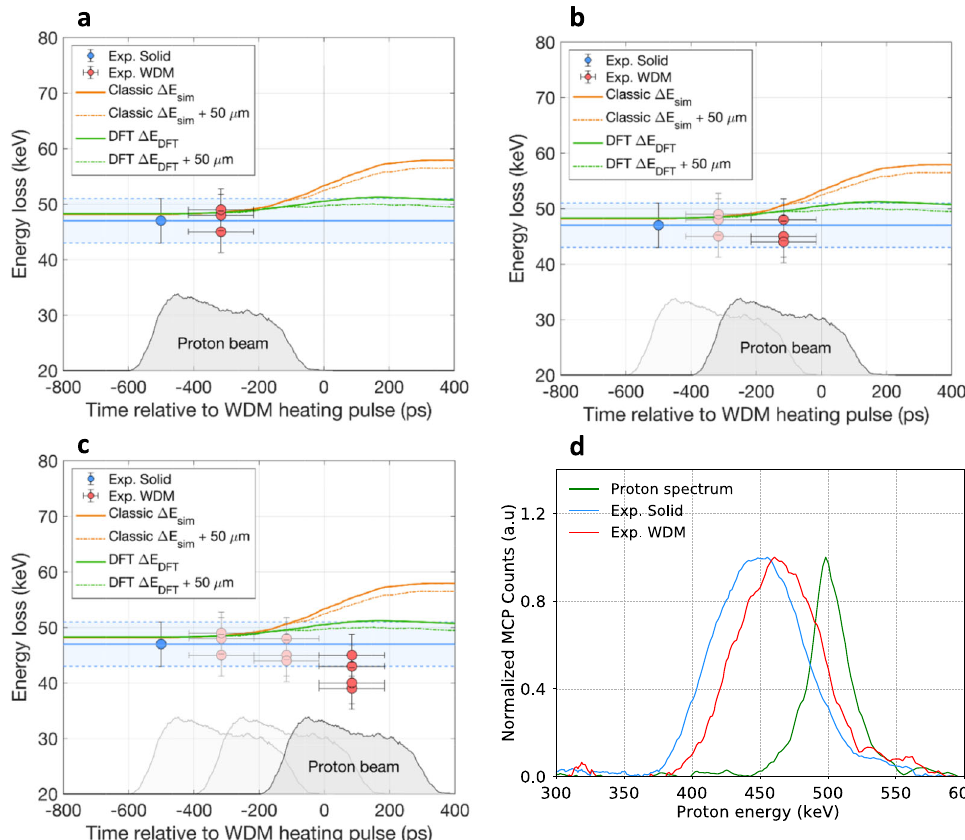
Fig. 6 Experimental energy-loss results. Proton energy-loss data as a function of time. The time t = 0 ps corresponds to the onset of the heater beam on the carbon target. The temporal shape of the probing proton bunch obtained with a FLUKA Monte-Carlo simulation is represented as a shaded grey pro fi le. The averaged measured energy loss in the solid target Δ E sol is plotted as a blue solid line, and the surrounding light blue band indicates the error σ = ± 5 keV. The orange and green curves represent the results of the classical and of the KS-DFT energy-loss calculation assuming the proton beam probing the target along its central axis (solid lines) and with a 50 μ m offset (dashed lines), respectively. a Energy-loss measurement at t = 316 ± 100 ps prior to the heater pulse onset. b Energy-loss measurement at t = 116 ± 100 ps prior to the heater pulse onset. c Energy-loss measurement at t = 86 ± 100 ps after the heater pulse onset. The vertical error bar is de fi ned a quadratic sum of systematic and statistical error on proton energy measurement. The horizontal error bar comes from uncertainty of synchronization between heater and proton beam and it is de fi ned as a quadratic sum of statistical error and uncertainty on proton time-of- fl ight estimation. d Comparison of the proton spectrum measured after free propagation in vacuum (averaged over 20 shots, green curve), the downshifted proton spectrum after passing the solid target (averaged over 35 shots, blue curve), and the downshifted proton spectrum after passing the WDM target (averaged over 4 shots, red curve). The vertical bars mark the spectra maxima